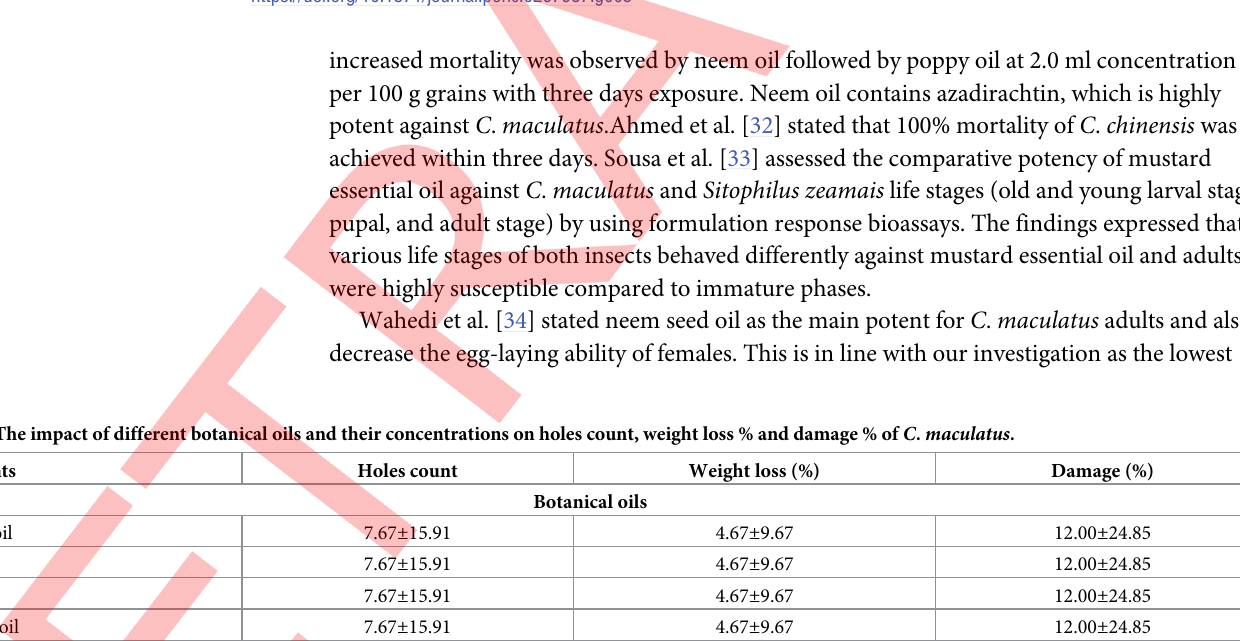
Fig 5. The impact of different botanical oils and their concentrations on holes count (a), weight loss (b) and damage caused (c) by C . maculatus .